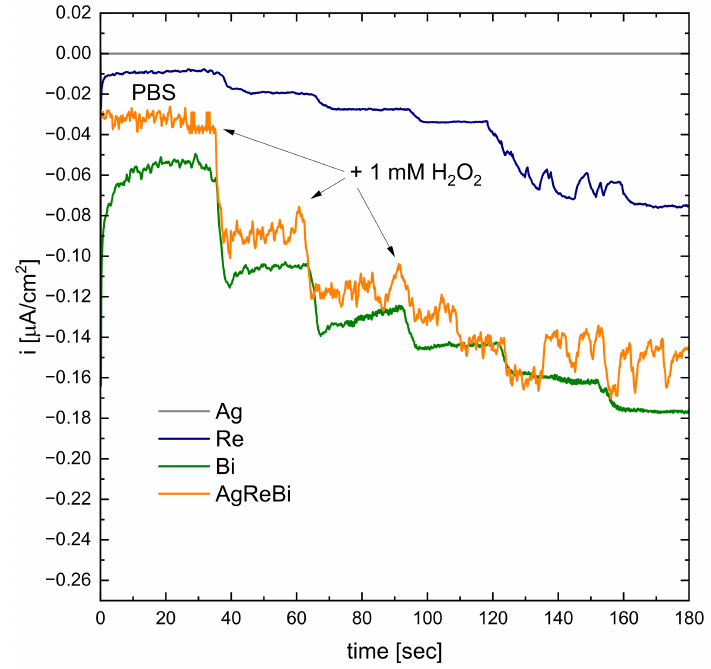
Figure 16. Amperometric measurements of hydrogen peroxide reduction with selected nanoparticles.